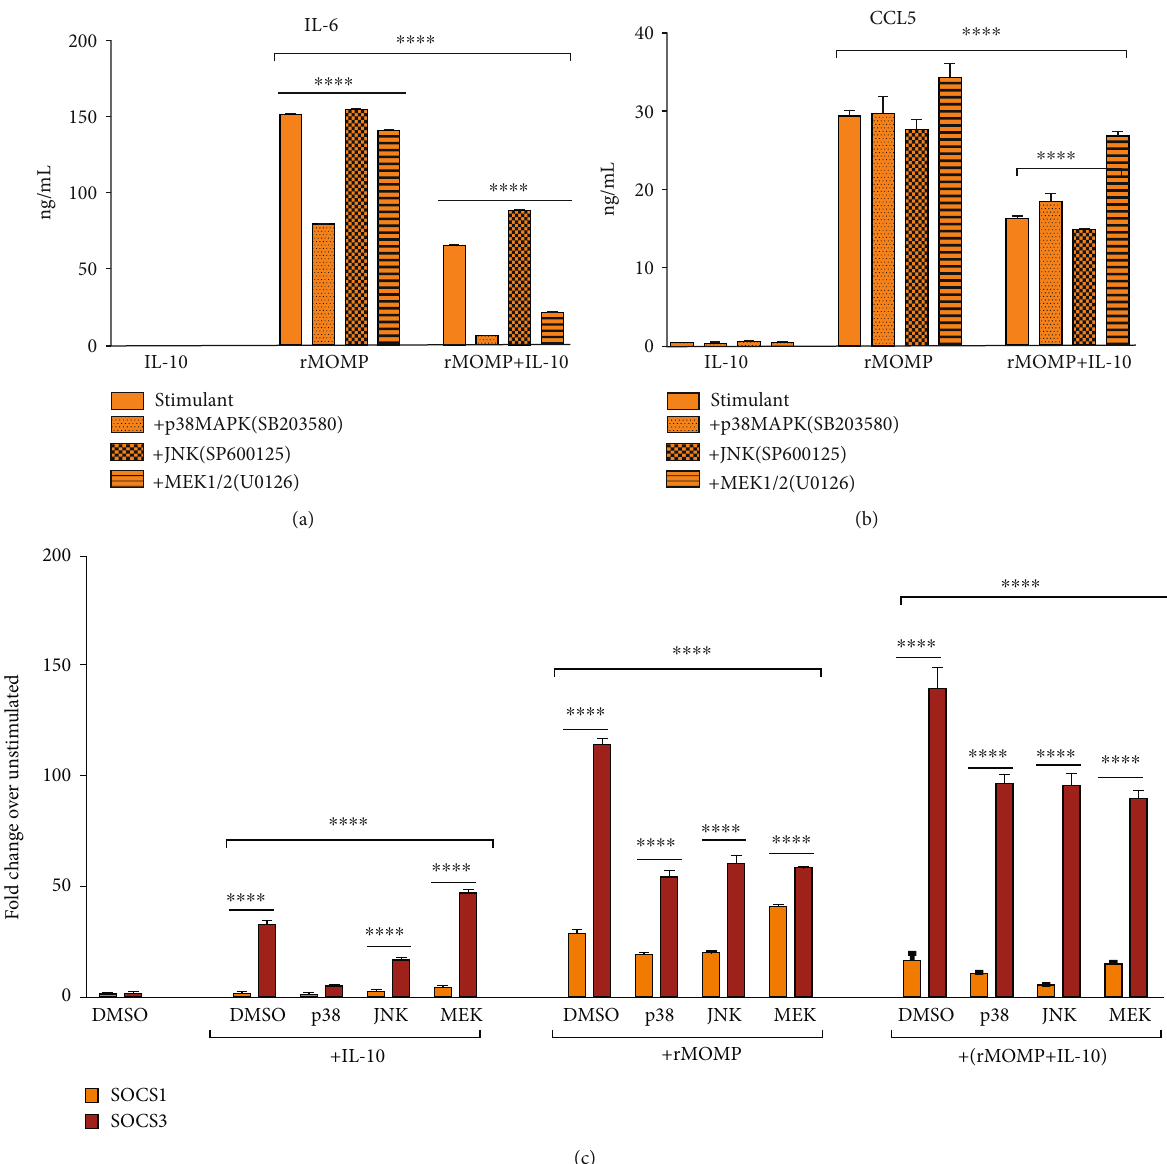
Figure 3: Speci fi c MAPK pathways regulate the IL-10-inhibition of in fl ammatory mediators in chlamydial macrophages and the induction of SOCS expression. Macrophages (10 6 /mL) were pre-incubated for 1h with MAPK pathway speci fi c-inhibitors (each at 20 μ M) for p38 (SB203580), JNK (SP600125) and MEK1/2 (UO126) followed by stimulation for 24 h with rMOMP (10 μ g/mL) in the presence and absence of IL-10 (10 ng/mL). IL-6 (A) and CCL5 (B) were measured by speci fi c ELISAs. TaqMan qRT-PCR was employed to quantify SOCS1 and SOCS3 mRNA gene transcripts (C). Results are presented as fold increase over the control. An asterisk indicates signi fi cant di ff erences ( P < 0.05), and P values were calculated as described in Figure 1 legend. Each bar represents the mean ± SD of samples run in triplicates. Each experiment was repeated 3